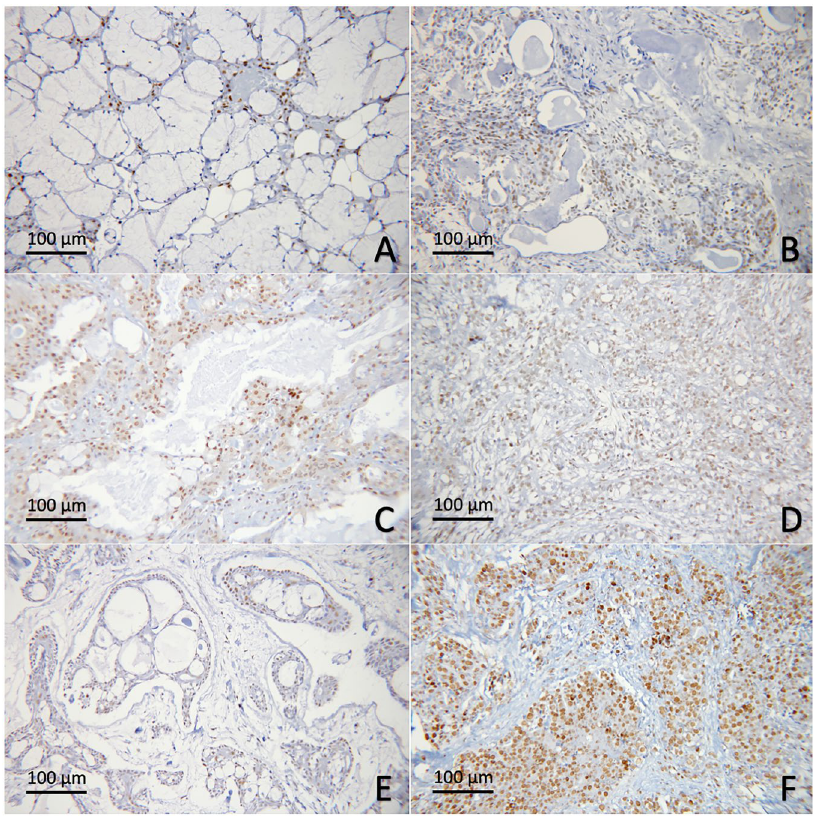
Figure 3. H3K9Ac in salivary gland neoplasms. ( A ) Normal salivary gland tissue; ( B ) PA; ( C ) low-grade MEC; ( D ) high-grade MEC; ( E ) ACC, cribriform/tubular subtype; ( F ) ACC, solid